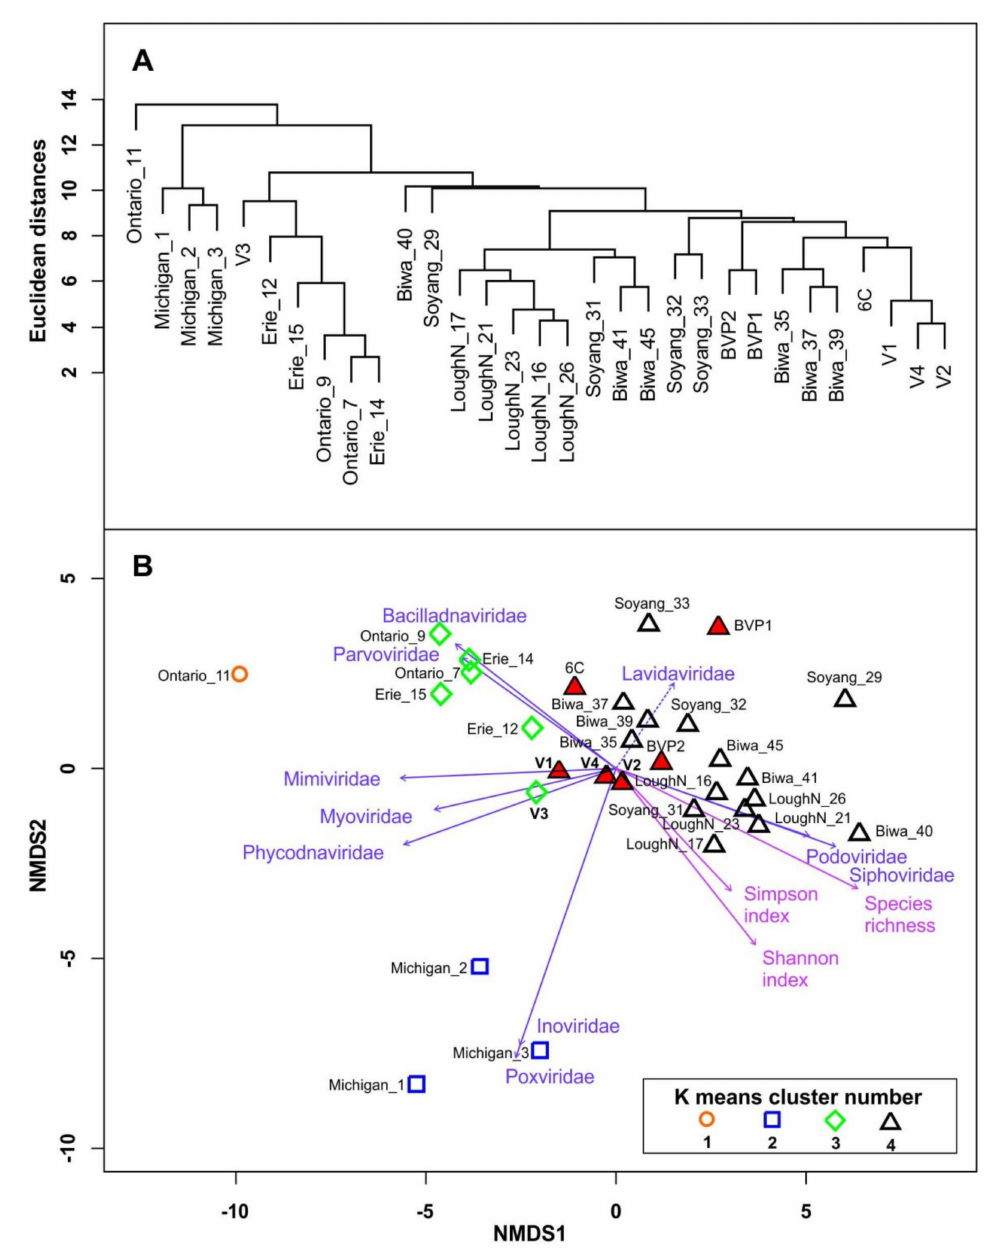
Figure 6. UPGMA (unweighted pair group method with arithmetic mean) cluster dendrogram ( A ) and NMDS biplot ( B ) showing the similarity of the samples (see Table 2) based on virotype counts (similarity of the taxonomic composition of viral communities). Blue arrows correspond to the vectors of gradient counts for ten dominant viral families in the samples (unreliable vector for the family Lavidaviridae is marked with a dotted line); pink arrows show biodiversity index gradients of viral communities; samples from Lake Baikal are marked in